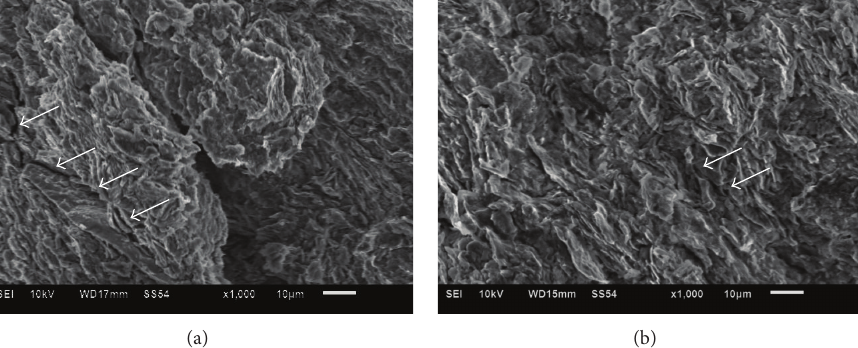
Figure 9: Secondary electron image of the fractured surface for samples consolidated at 800 ∘ C/min/500 ∘ C/3min in (a) and at 400 ∘ C/500 ∘ C/3min in (b).